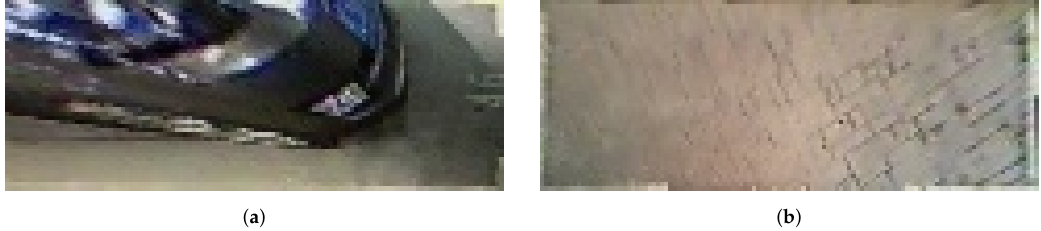
Figure 9. Training samples for vacant parking slot classification. ( a ) a negative sample: a non-vacant regularized parking slot. ( b ) a positive sample: a vacant regularized parking